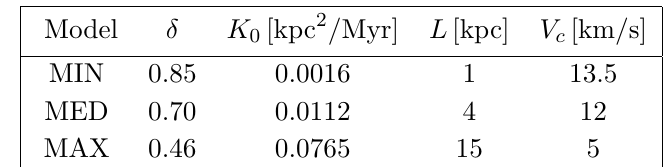
Figure 2 . Positron spectrum at production for the two dark partner decays modes, with S2B (3B) in blue (red). The speci(cid:12)c parameters are as labelled.